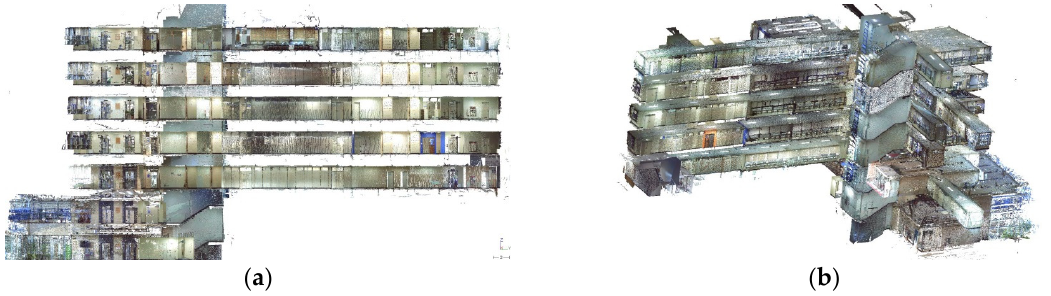
Figure 9. ( a ) Lateral view; and ( b ) 3D view of the ETRI building point cloud.